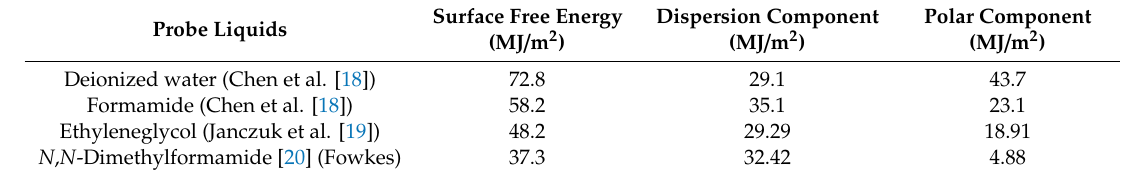
Table 2. Surface free energy, dispersion component, and polar component of probe liquids on tea leaf surfaces.